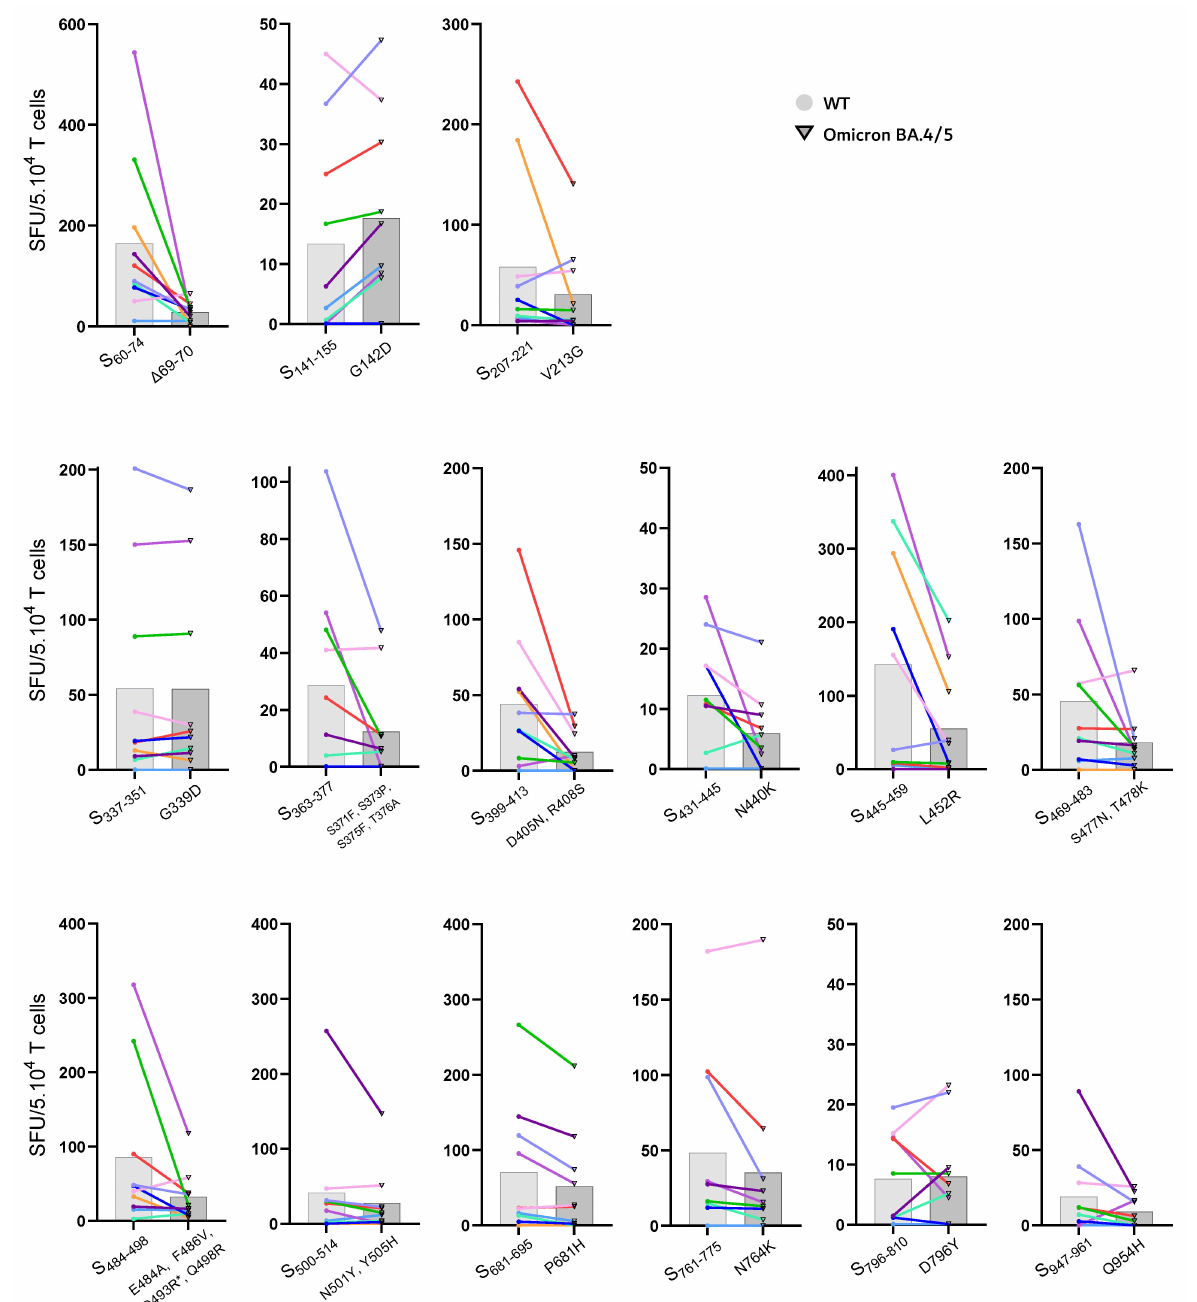
Figure 3. In T cell lines obtained from vaccinees, IFN- G responses are reduced to various, but not all, spike epitopes containing BA.4/BA.5 mutations compared to the original D614G wildtype (WT) spike epitopes. Polyclonal spike enriched T cell lines were restimulated for 24 h with individual WT spike epitopes or corresponding sequences of the Omicron BA.4/BA.5 variants and analyzed for IFN- γ producing spot-forming cells (SFU) per 5 × 10 4 T cells as quantified by an IFN- G ELISPOT assay. Responses of each subject are represented by pairs of symbols (closed colored dots for WT restimulation versus open triangles with black border for BA.4/5 restimulation) connected with a colored line per subject. On the X -axis, WT (left) and Omicron BA.4/BA.5 (right) peptide pairs are indicated as location of first and last amino acid position within WT spike protein (S), and the Omicron BA.4/BA.5 amino acid mutation(s) or deletions. Notice, different Y -axis scales were used to be able to optimally visualize differences between subjects for each spike